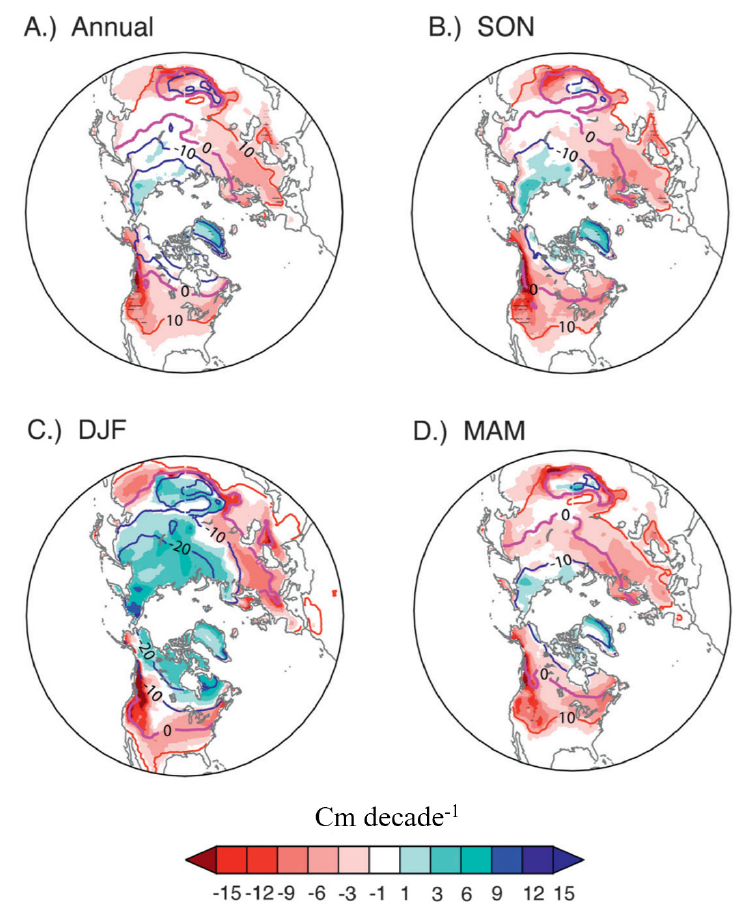
Figure 5. Projected trends in snowfall (2006–2100; cm decade − 1 ): ( A ) Annual, ( B ) September–November (SON), ( C ) December–February (DJF), and ( D ) March–May (MAM) [68]. The map reproduced from [58] with permission from Journal of Climate.